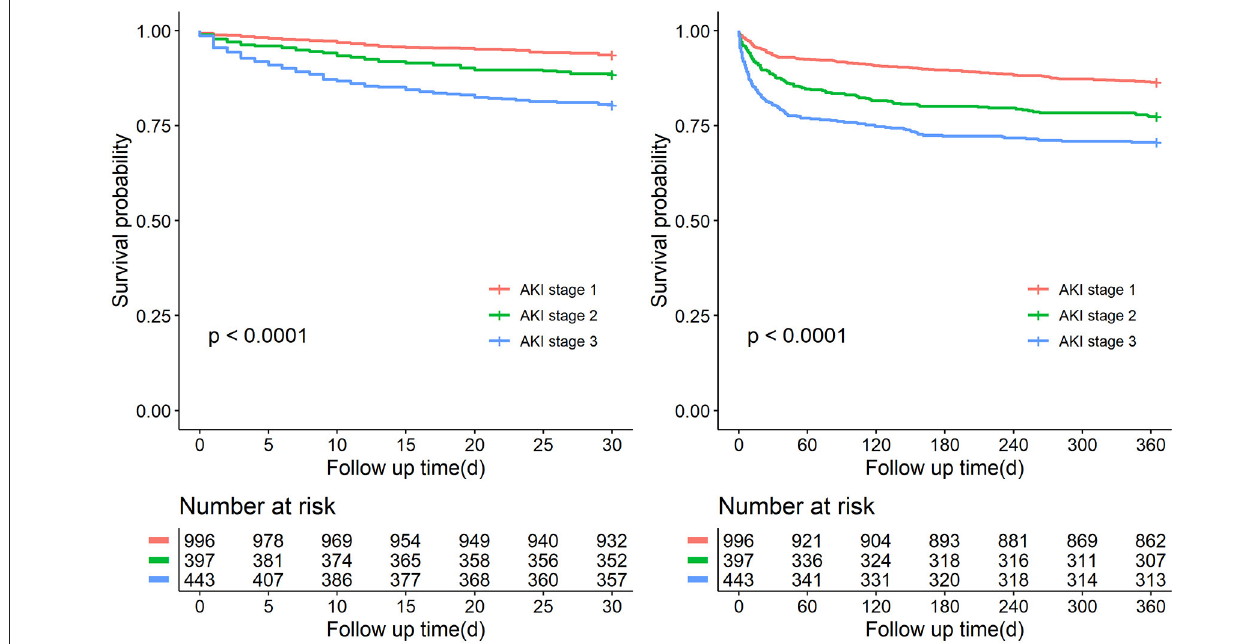
FIGURE 2 | Patient survival probability within 30 days and 1 year of patients with different stages of AKI.